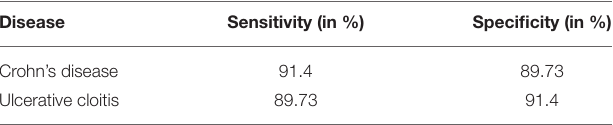
TABLE 3 | Sensitivity and specificity of CNN per diagnosis: this table displays the sensitivity and specificity of the convolutional neural network (CNN) trained and tested on the data from the Follow-Up-2018